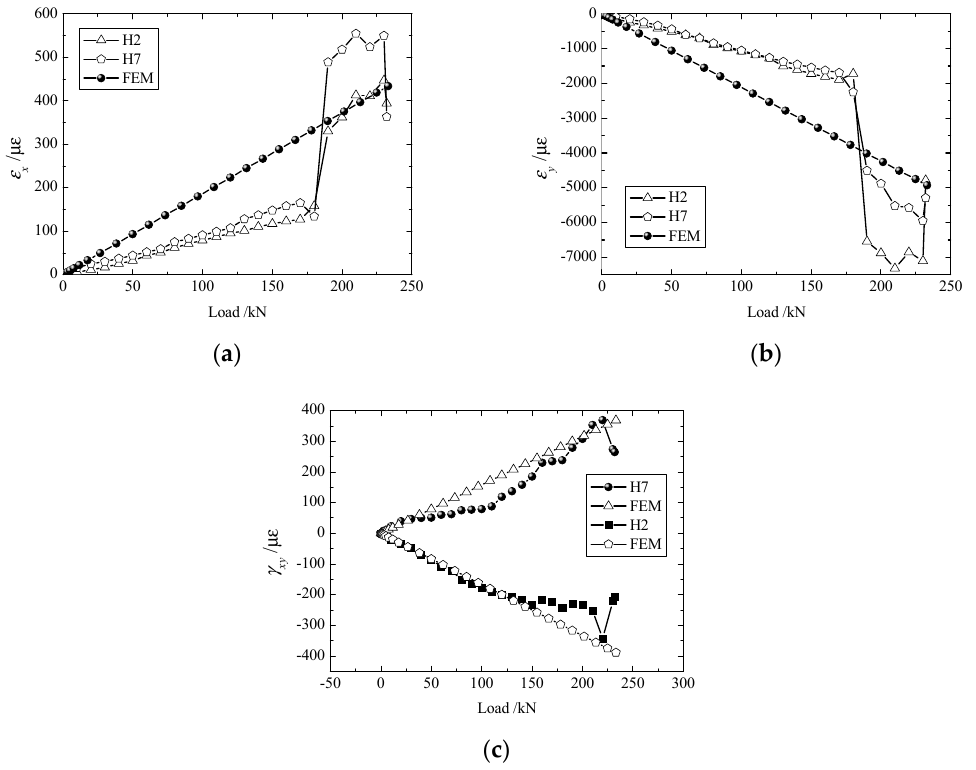
ε ε ; ( b ) ; and ( c ) xy y